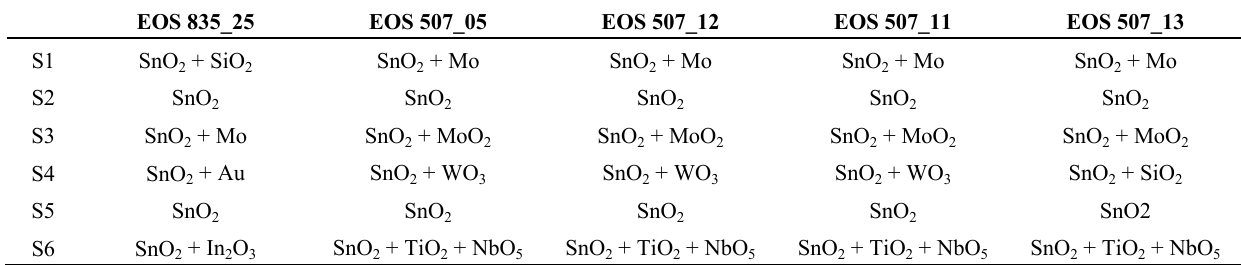
Table 1. Sensor arrays of the five electronic noses employed for the field